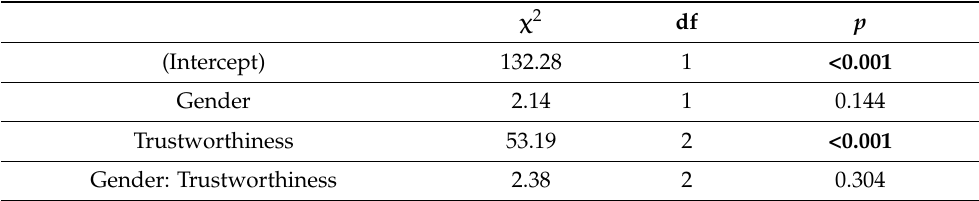
Table 6. Results of Wald χ 2 test for the lmm on h parameters. df = degree of freedom. Significant p values are reported in bold.